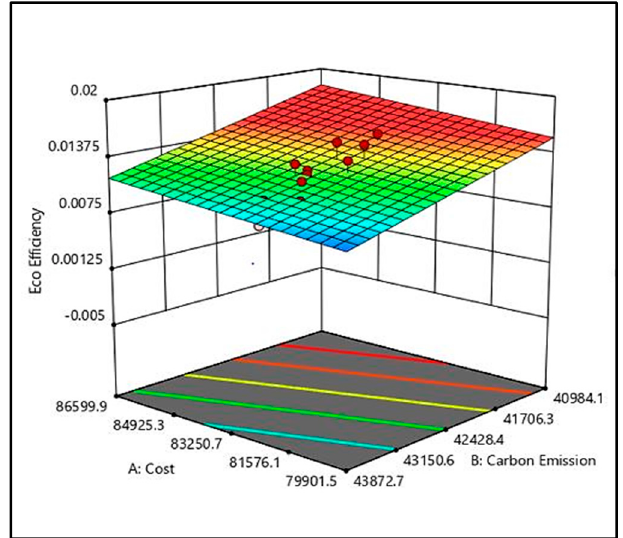
Figure 11. Response surface graph of fly ash based concrete used for single story houses.